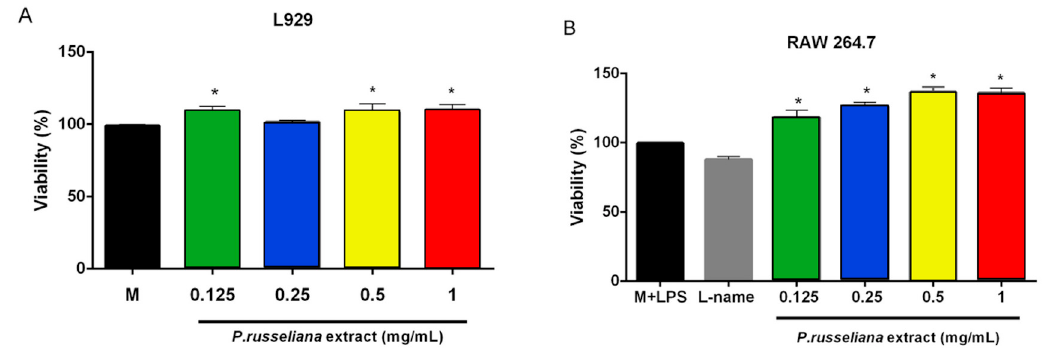
Figure 1. Effects of P. russeliana extract studied at different concentrations on L929 cell viability ( A ) and RAW264.7 cell viability ( B ). L-name: N -( γ )-nitro- L -arginine methyl ester (* p < 0.05).